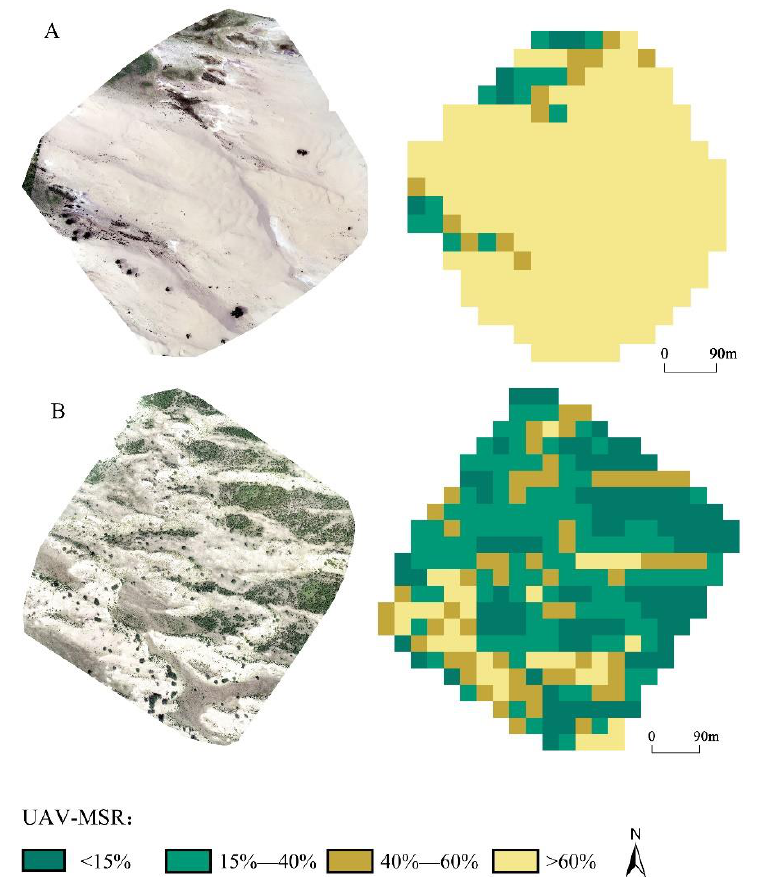
Figure 5. Results of the UAV-MSR: ( A ) and ( B ) are two UAV images and their UAV-MSR. Image ( A ) is composed of large mobile dunes. In image ( B ), the semi-fixed dunes and inter-dune land with higher vegetation coverage are the main land types.